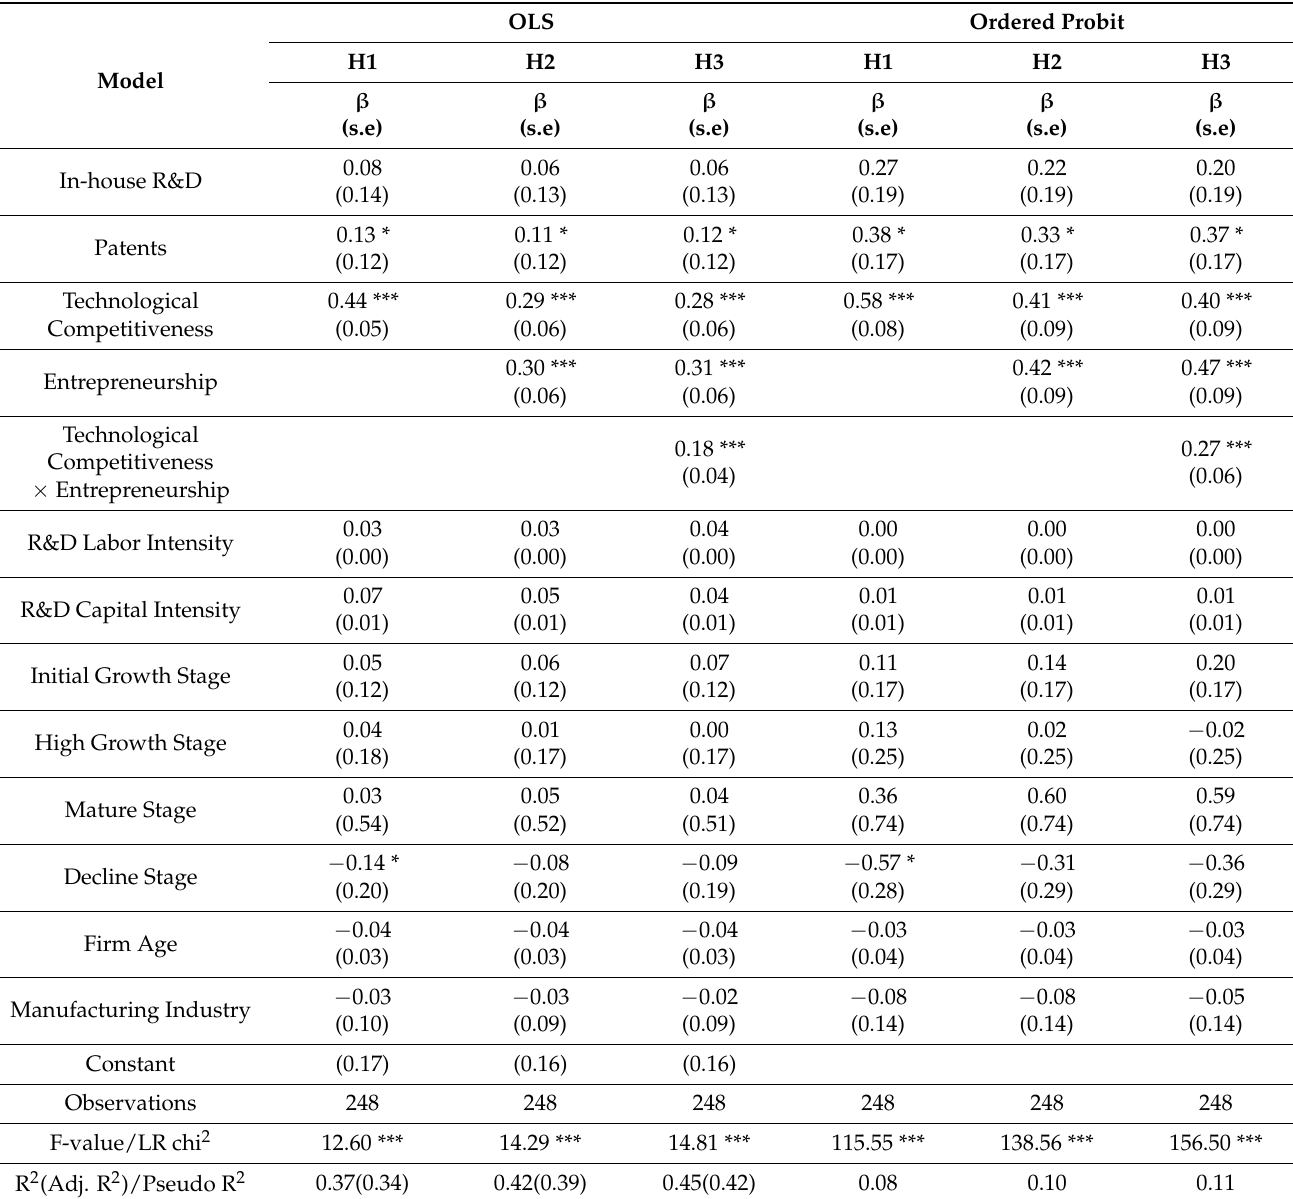
Table 1. Analysis